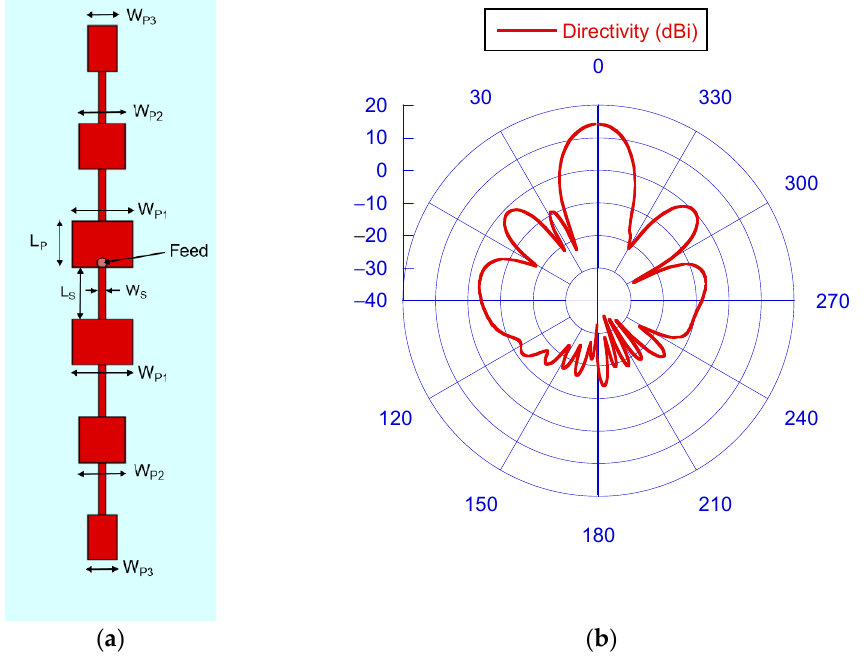
Figure 4. Schematic of the realized serial patch array antenna ( a ) and its radiation pattern ( b ). Theta = 0 ◦ corresponds to the normal at the air–dielectric interface of the array antenna.